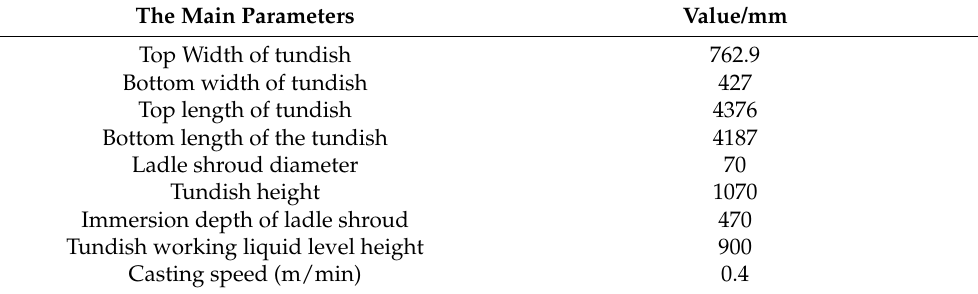
Figure 2. Tundish geometric model and the planes used in the mathematic model. Table 1. The specific parameters of the tundish applied in the calculations. The Main Parameters